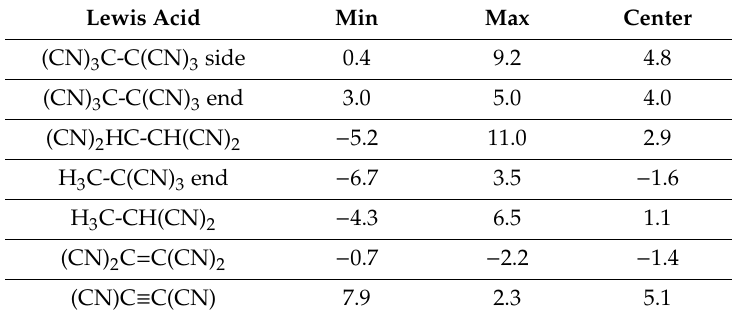
Table 3. Changes in C ≡ N vibrational frequencies (cm − 1 ) caused by complexation with NH 3